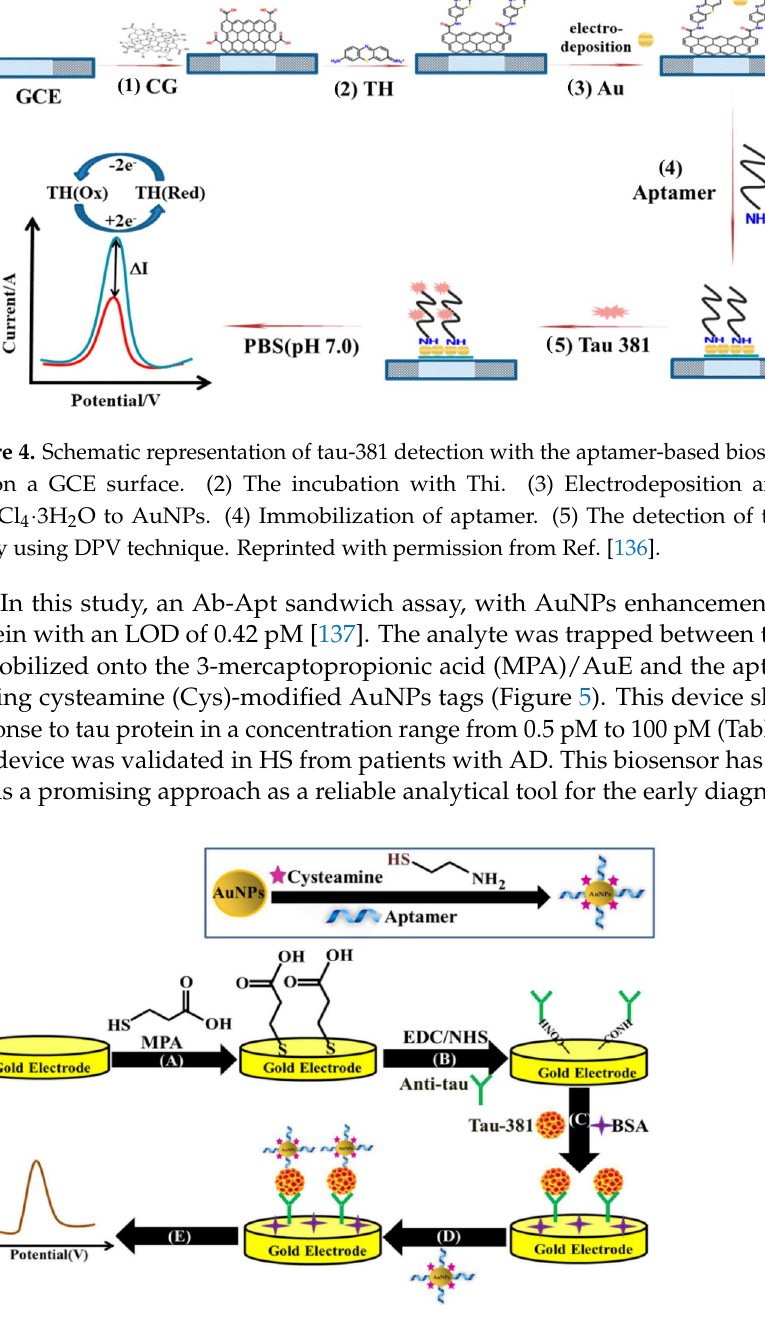
Figure 5. Preparation of Ab-Apt sandwich biosensor for detection of tau-381 protein: (A) Self-assembly of MPA at AuE. (B) EDC/NHS activation and anti-tau antibody immobilization. (C) Free sites blocked with BSA followed by immunoreaction with tau-381. (D) Affinity interaction the aptamer-Au-Cys bioconjugate. (E) Detection of tau-381 levels by using DPV. Reprinted with permission from Ref. [137].